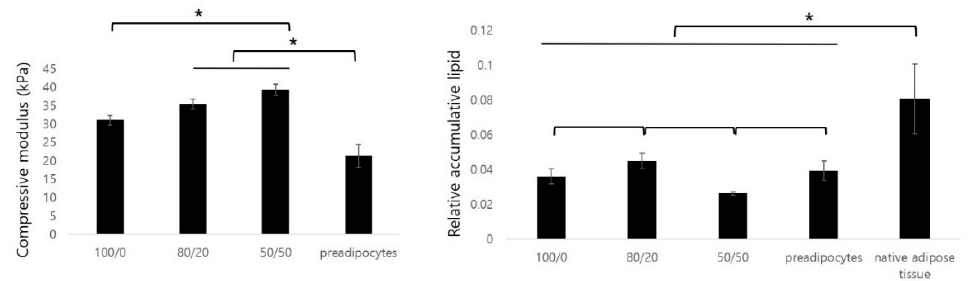
Figure 8. Compressive modulus and relative accumulative lipids for each group of the 12-week in vivo samples (* p < 0.05).